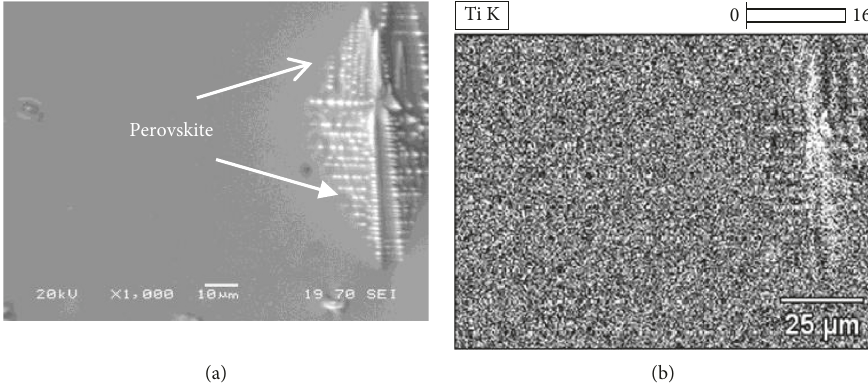
Figure 8: Area scanning mapping of Ti and EDS in 2# sample with 2% B